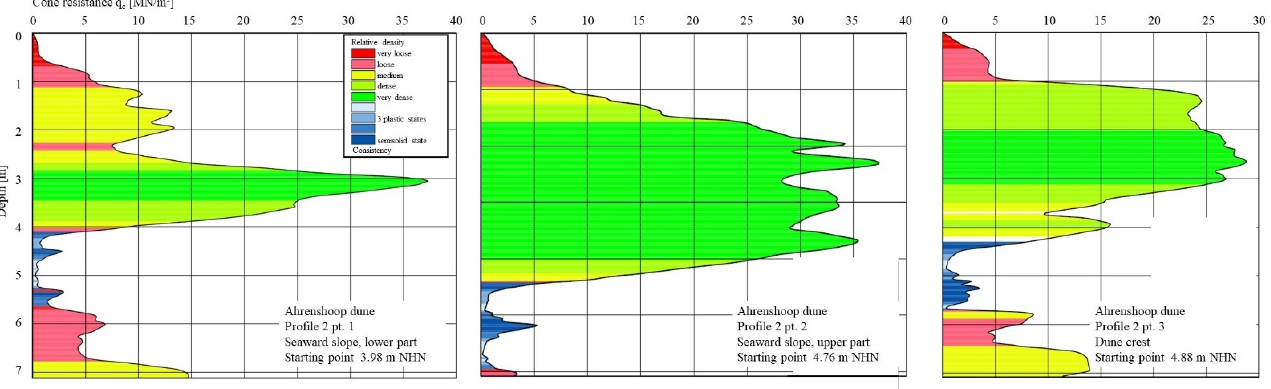
Figure 5. Representative results of the cone penetration testing in Ahrenshoop (3 out of 25).